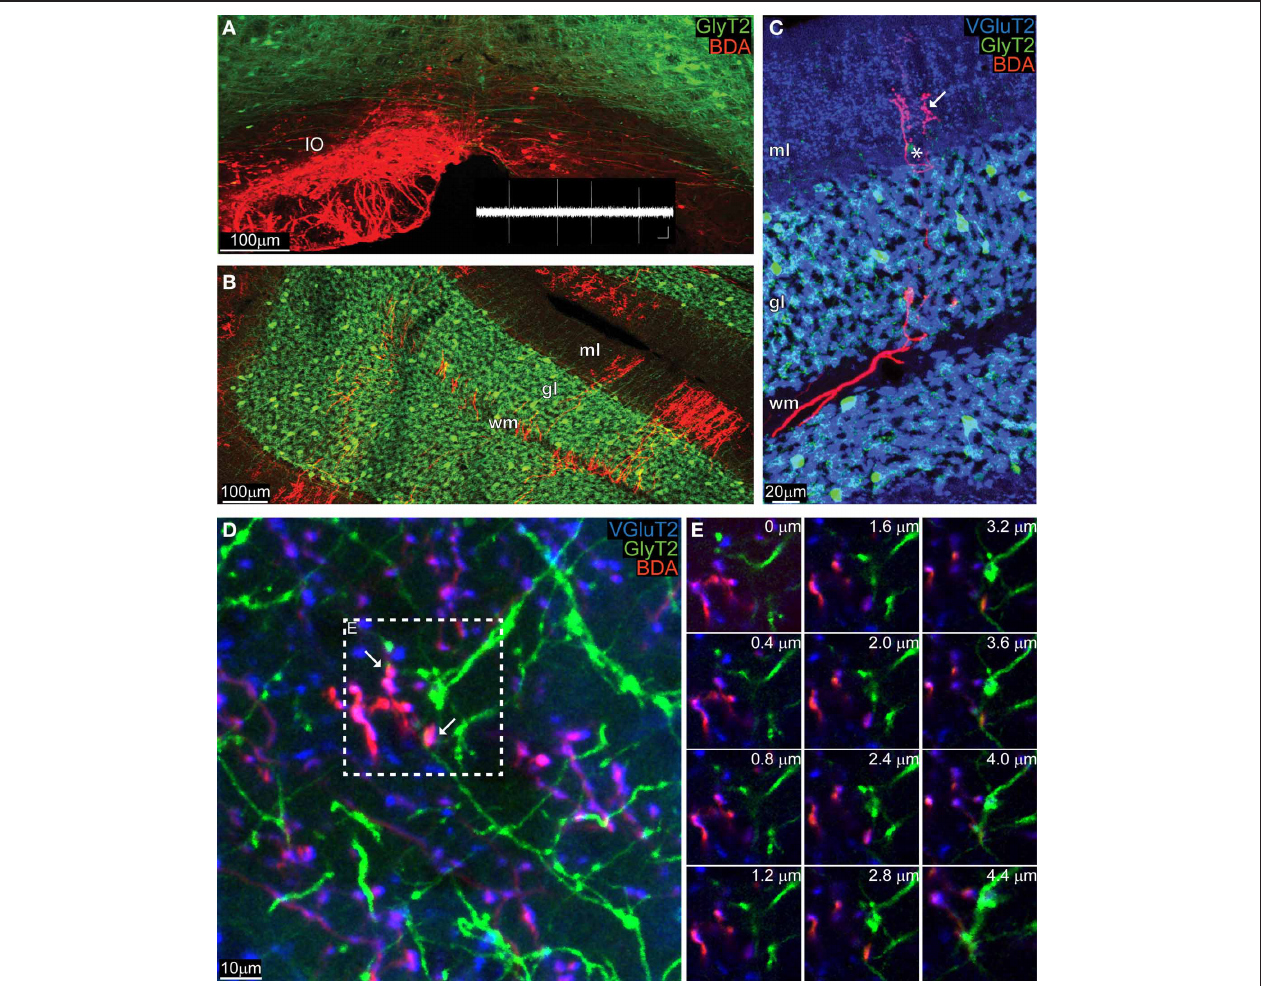
FIGURE 2 | Anatomically marked CFs co-stain with VGlut2 in the ML, but not with GoC dendrites. (A) Maximum intensity projection of a low magnification image (10 µ m thick) of the IO of a GlyT2-EGFP mouse, in which all glycinergic neurons (GoC included) are green. The animal was unilaterally injected with BDA in the left IO, and the BDA was visualized with a red fluorochrome. The inset in white reproduces a typical olivary neuron firing pattern (scalebar: 0.5mV, 500ms). (B) View of the cerebellar cortex of the same GlyT2-EGFP mouse presented in (A) (maximum intensity projection of a 10 µ m thick slice). The BDA along the olivary axon clearly stained CFs, which entered in the white matter (WM), passed through the GL and reached the ML. (C) Example picture (maximum intensity projection, 5 µ m thick)